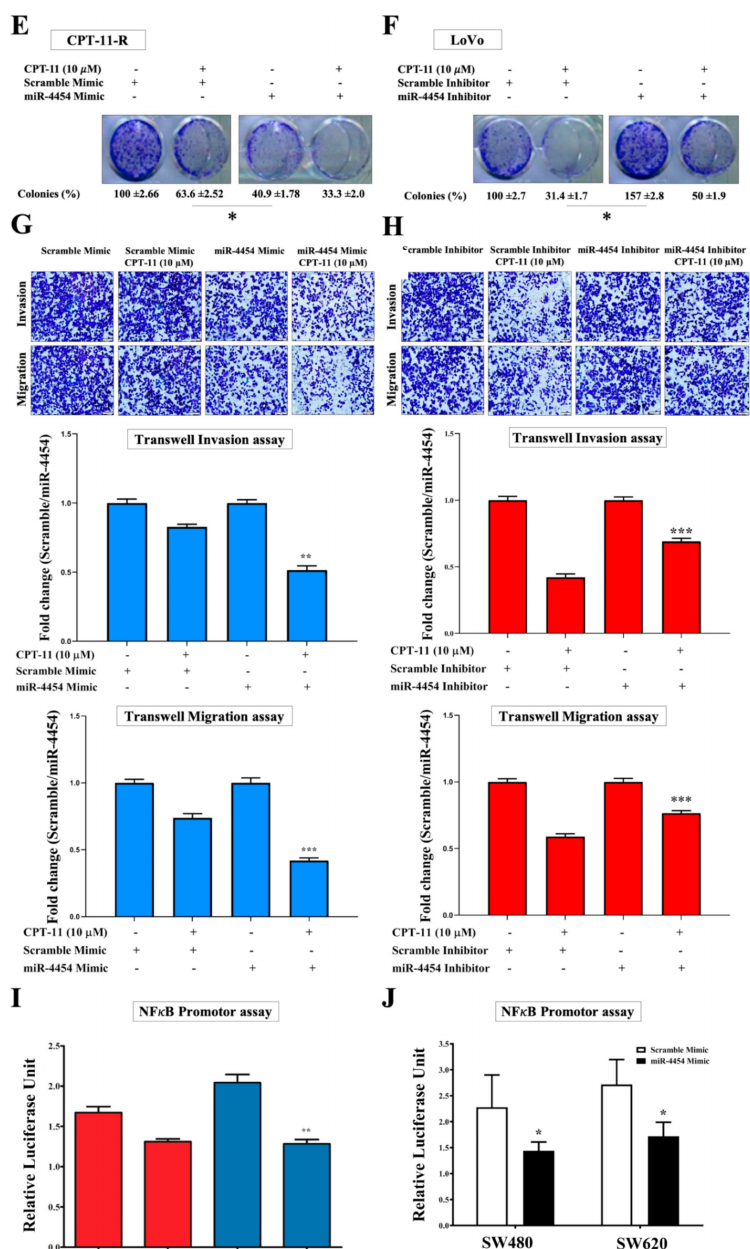
Figure 6. MiR-4454 suppresses colon cancer cell growth, invasion, and migration through the GNL3L and NF- κ B pathways. ( A ) Annexin V apoptosis cell flow cytometry analysis for ectopic overexpression of miR-4454, which enhances the chemo sensitization effect of CPT-11-R cells treated with CPT-11 (10 µ M) at 48 h time point (upper & lower). ( B ) Inhibition of endogenous miR-4454 promotes LoVo cell chemoresistance to CPT-11 (10 µ M) at 48 h time point (upper & lower) and fold change normalized with scramble mimic for CPT-11-R and scramble inhibitor for LoVo cell line. ( C ) Cell cycle G2 / M phase analysis during ectopic overexpression of miR-4454 in the CPT-11-R cells (upper & lower) and ( D ) during endogenous miR-4454 inhibition in LoVo cells (upper & lower). ( E , F ) Colony formation ability of CPT-11-R cells and LoVo cells. ( G ) Results from the invasion / migration analysis of ectopically overexpressed miR-4454 in CPT-11-R cells (upper & lower). ( H ) Results from the invasion / migration analysis of the inhibited endogenous miR-4454 in LoVo cells (upper & lower) (scale bar: 100 µ m). ( I , J ) Results from the promoter assay analysis of the relative luciferase NF- κ B promoter signal unit reduction in miR-4454-overexpressed groups. The results are presented as mean ± standard error of the mean ( n = 3). * p < 0.05, ** p < 0.01, *** p < 0.001 compared to